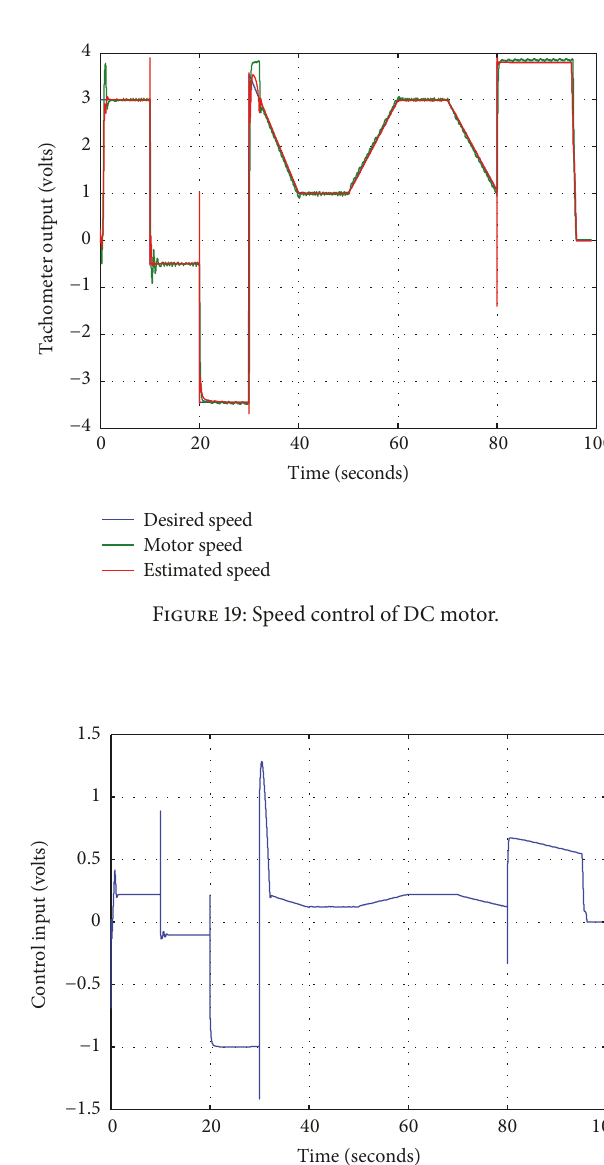
Figure 20: Control input to speed control